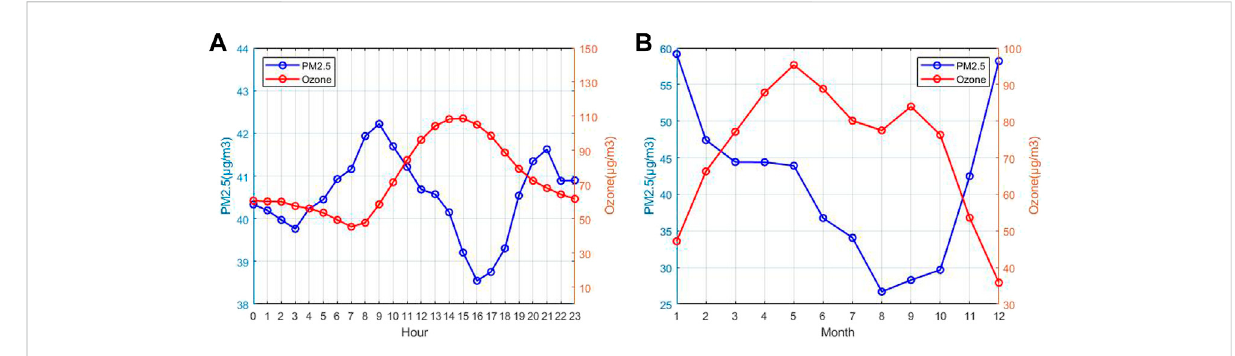
FIGURE 2 The hourly and seasonal means of PM 2.5 and ozone concentrations in Shanghai, (A) diurnal changes and (B) monthly changes from 2014 to 2020.